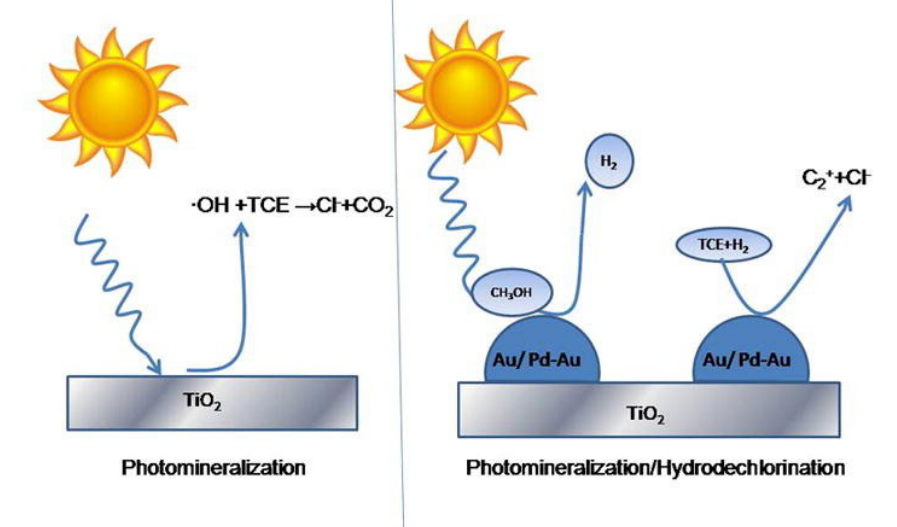
Figure 5. Photomineralization and photomineralization/hydro dechlorination mechanisms. Repro- duced with permission from ref. [45]. Copyright 2017 Elsevier.